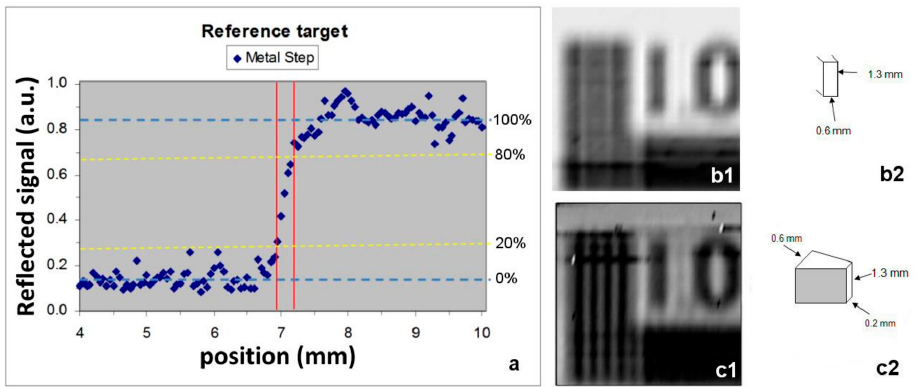
Figure 2. Resolution measurement: ( a ) Knife-edge method using ( c2 ) probe. ( b1 ) Heidenhain image with ( b2 ) probe (0.6 × 1.3 mm 2 ). ( c1 ) Heidenhain image with tapered ( c2 ) probe (0.2 × 1.3 mm 2 ).